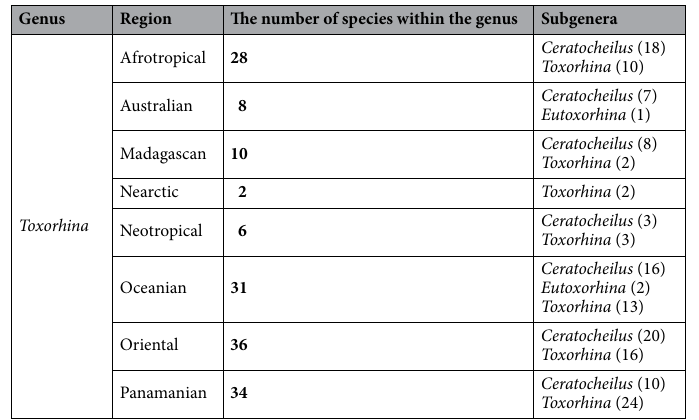
Table 1. Distribution of Toxorhina in recent fauna (biogeographic divisions after Holt et al. 1 ; distribution and data according to Oosterbroek 2 ). Significant values are in bold.